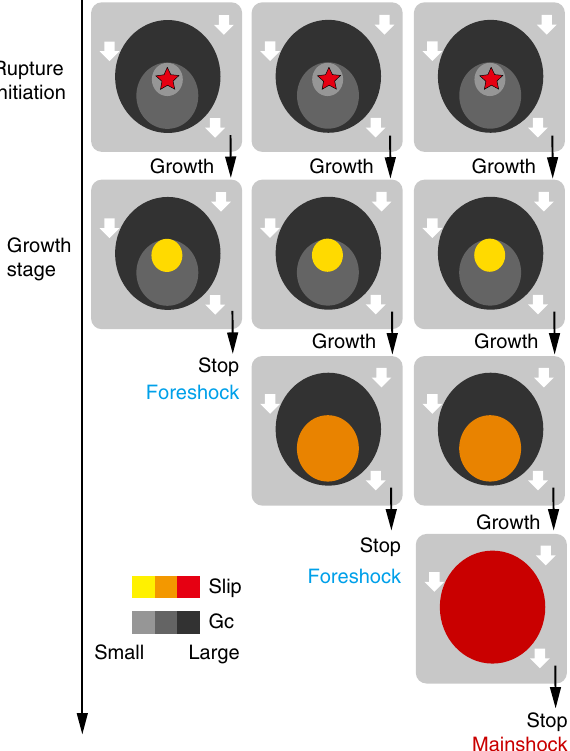
Fig. 5 Conceptual hierarchical patch model. The hierarchical structure, de fi ned by the different patch sizes in the fi gure, controls the overall earthquake behaviours. A large earthquake can be interpreted as the result of a cascade-up process that initiated from a small-patch